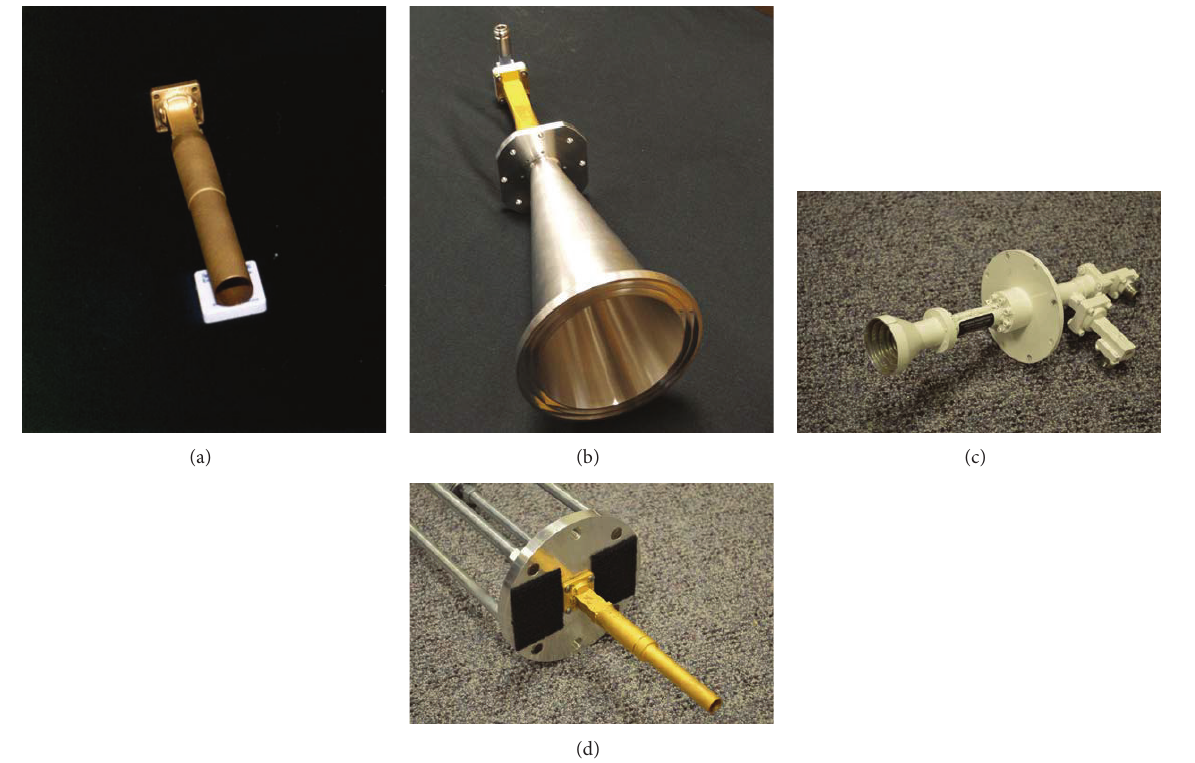
Figure 3: (a) SN 330. (b) SN 401. (c) SN 1057. (d) SN